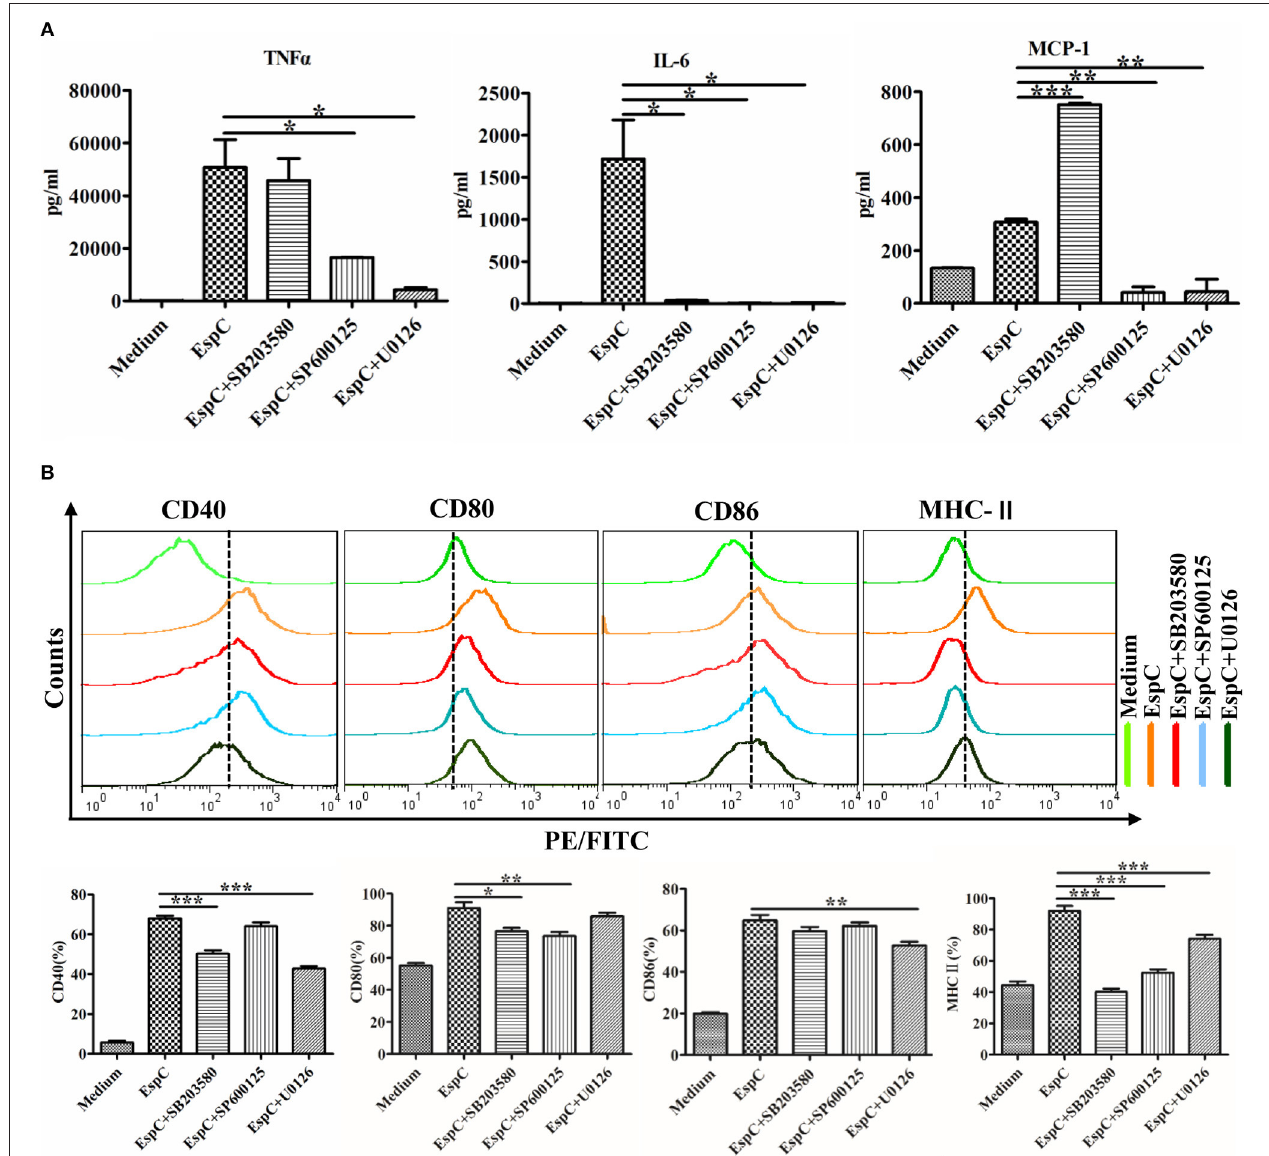
FIGURE 5 | Involvement of the p38, JNK, and ERK pathways in EspC protein-induced production of pro-inflammatory cytokines and expression of costimulatory and MHC molecules. RAW264.7 cells were pretreated with pharmacological inhibitors of p38 (SB203580, 10 µ M), JNK (SP600125, 25 µ M), or ERK (U0126, 10 µ M) or with dimethyl sulfoxide (vehicle control) for 1h before being stimulated with 5 µ g/mL EspC for 24h. (A) Amounts of TNF- α , IL-6, and MCP-1 present in the culture medium were measured by ELISA. (B) The expression of CD40, CD80, CD86, and MHC-II was analyzed by flow cytometry. Values indicate means ± SEMs from three independent experiments; * p < 0.05, ** p < 0.01, *** p <